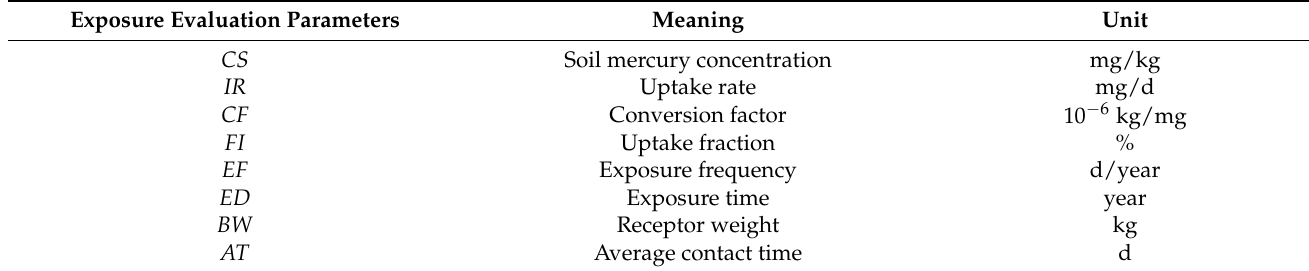
Table 2. Parameter meanings and unit of exposure assessment model.